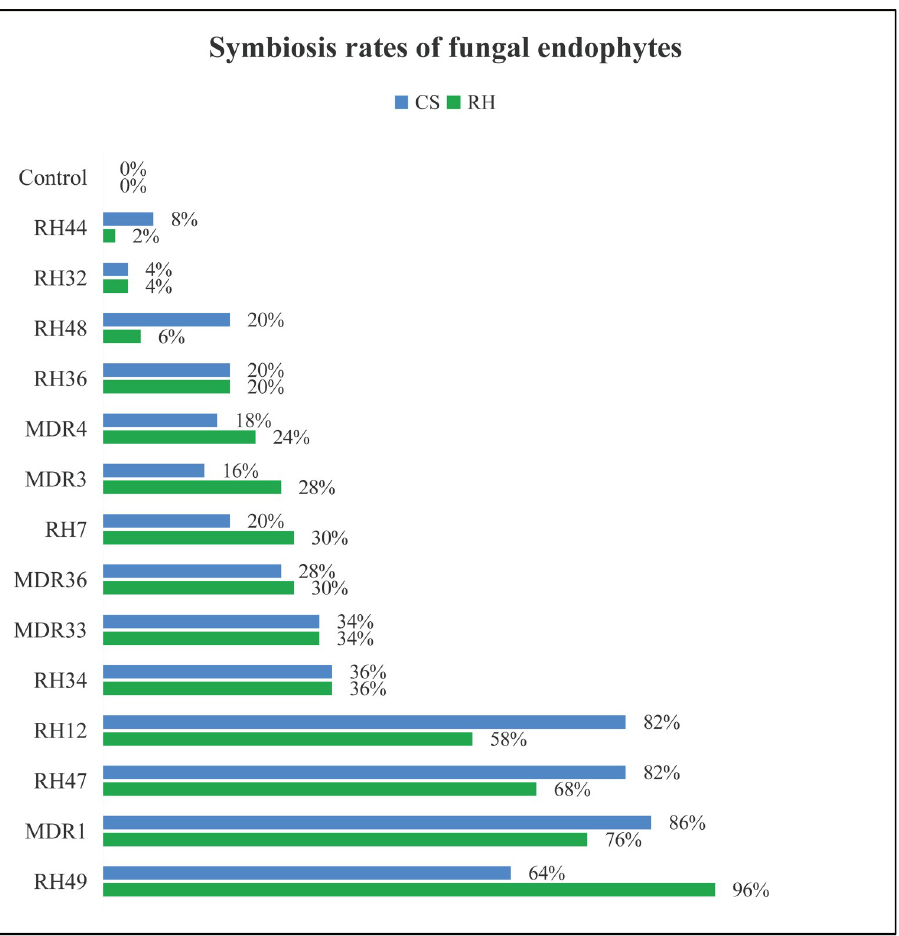
Fig 1. Symbiosis rates of fungal endophytes of in vitro grape leaves after infection with endophytic fungal strains.